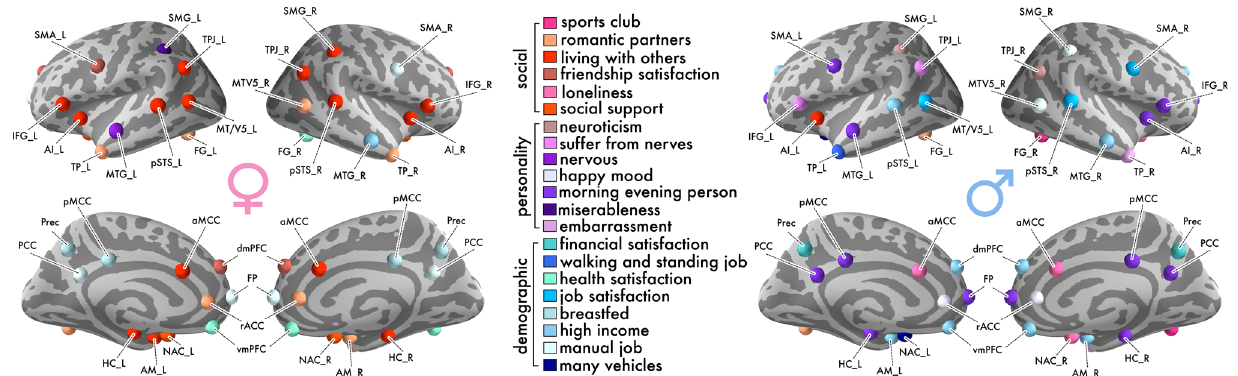
Fig. 1 Social brain variation is preferentially explained by social traits in women, and by personality and demographic traits in men. Extending previous social neuroscience studies, the richness of the UK Biobank resource allowed uniquely isolating marginal correlations, which prevail over a wide variety of competing explanatory factors. A generative probabilistic model was estimated for each of the 36 social brain regions in our population sample of middle- aged adults. These region-by-region analyses revealed numerous dominant speci fi c (i.e., partial) trait associations in social brain structure. Colors indicate which individual traits have the largest magnitude (i.e., strongest positive or negative association) in explaining its regional gray matter volume, relative to the other 39 out of 40 total examined traits (cf. Supplementary Data 1). Red indicates markers in the social trait category, purple indicates the personality trait category, and blue indicates the demographic trait category. Sharing one ’ s home with other individuals was the single most frequent trait association to show the largest magnitude in explaining social brain volume for women, in atlas regions including the AI, AM, HC, IFG TPJ and pSTS (left). The personality trait of being a morning person was the most common trait to show the strongest trait association in social brain structure for men, in atlas regions including the AI, HC, FP, IFG, PCC and pMCC (right). Dominant trait associations from the partial correlation analysis are shown in Supplementary Fig. 1 (cf. Table 3 and Supplementary Data 2 for a description of the social brain region